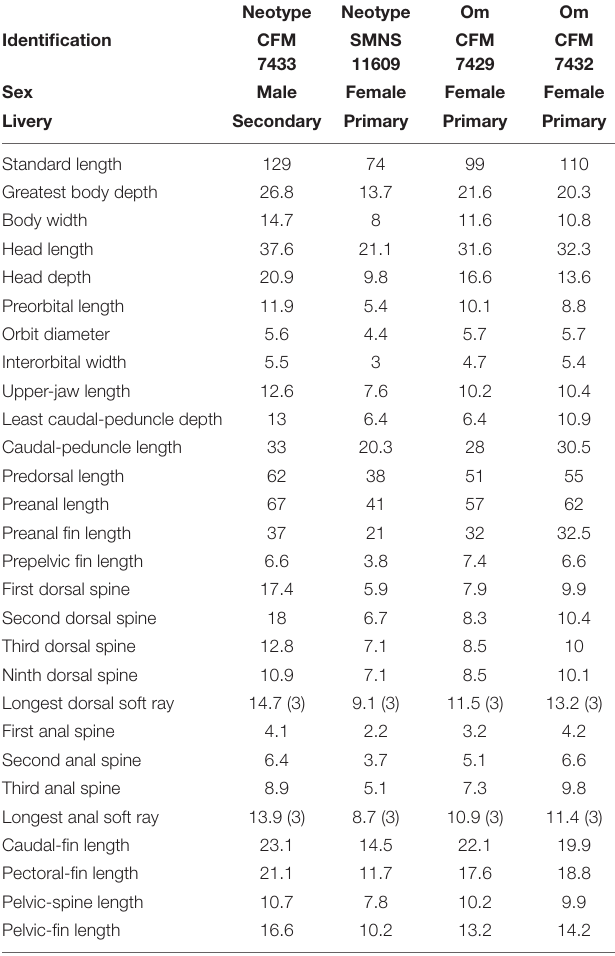
TABLE 3 | Measurements of the neotype and other material (Om) of Coris julis